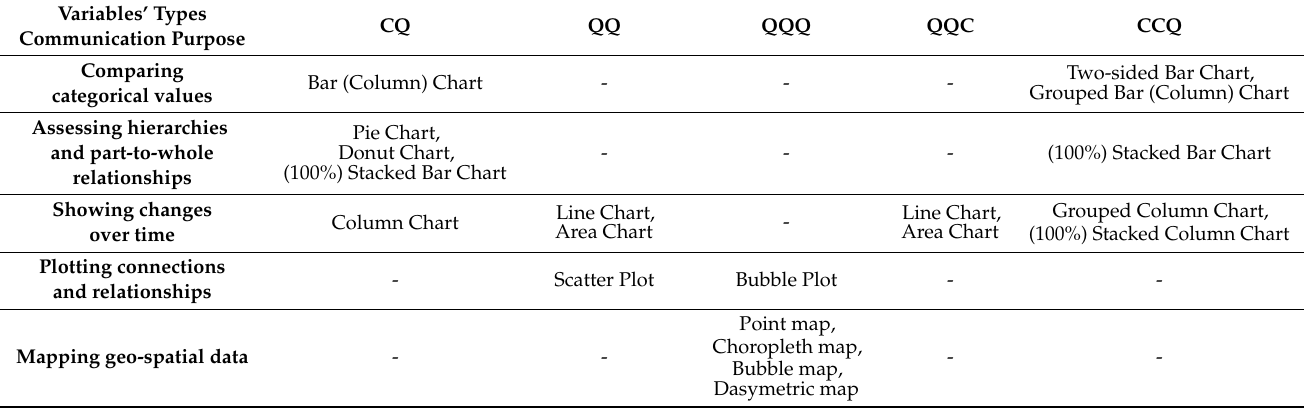
Table 1. Decision table of data visualization format’s selection (CQ—1 categorical variable, 1 quanti- tative variable, QQ—2 quantitative variables, QQQ—3 quantitative variables, QQC—2 quantitative variables, 1 categorical variable, CCQ—2 categorical variables, 1 quantitative